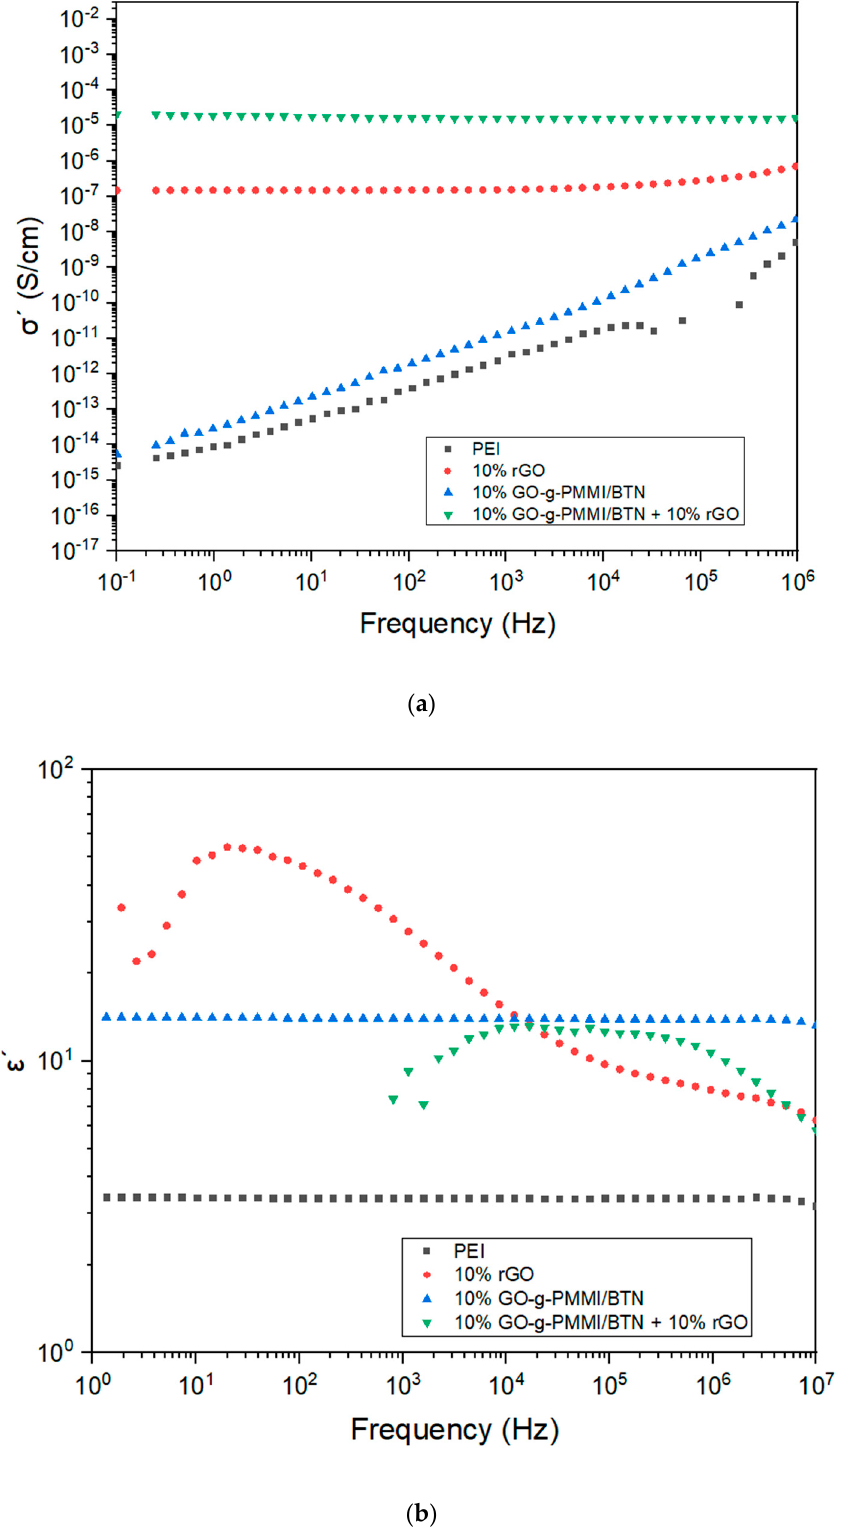
Figure 10. Conductivity ( a ) and dielectric permittivity ( b ) of PEI and nanocomposites filled with rGO, GO-g-PMMI/BTN and GO-g-PMMI/BTN+10% rGO as a function of the frequency.